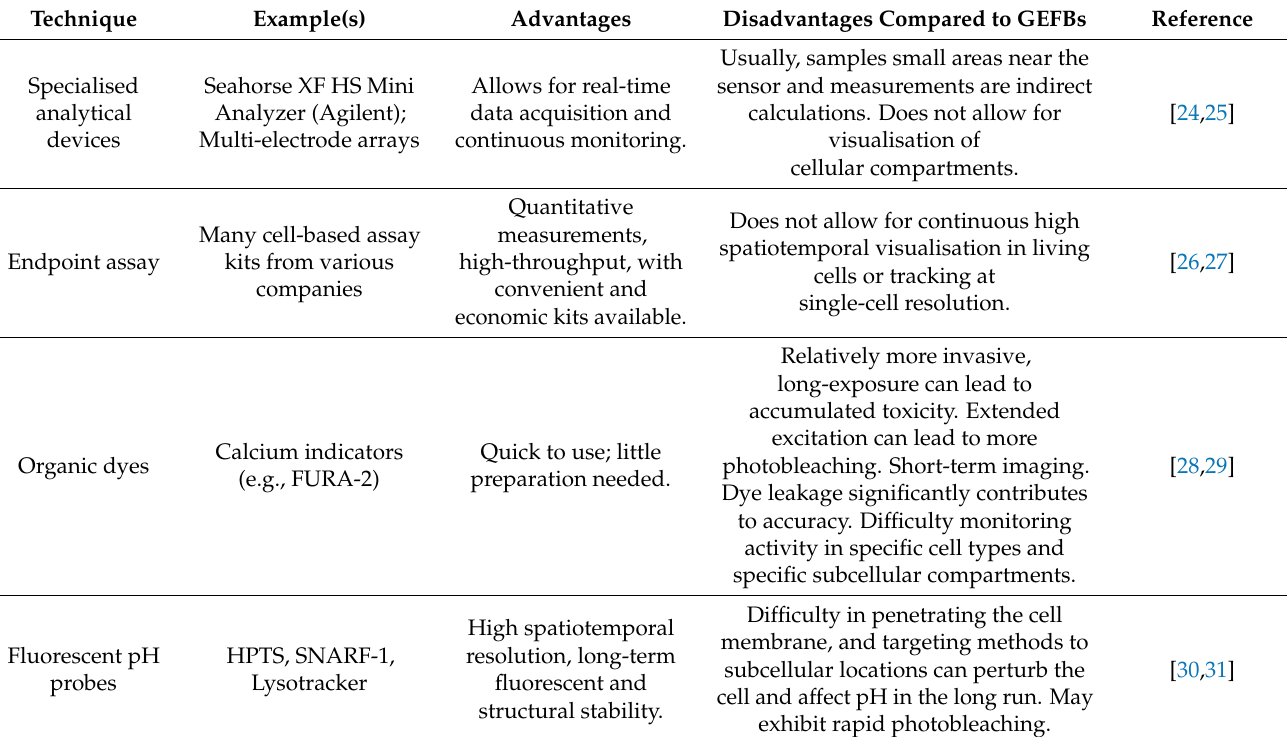
Table 1. Comparative analysis of other methods to